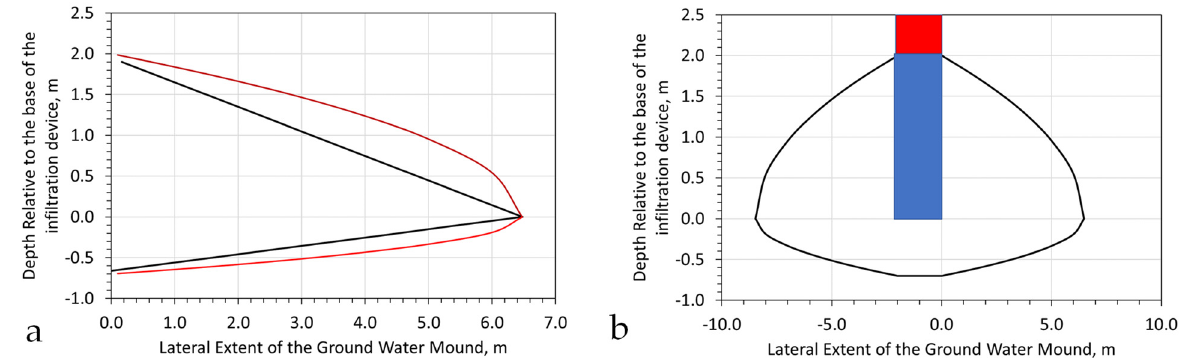
Figure A21. Groundwater mound during formation. ( a ), Lateral extent from the infiltration device versus depth relative to the base of the infiltration device. Here, 0 m = base of the device (datum), and 2 m = top of the water column within the infiltration device. Black is the form calculated from the permeability data; Red = the associated Dupuit envelope. ( b ), Dupuit envelope for the groundwater mound. Blue = water within the infiltration device; Red = air filled portion of the infiltration device.